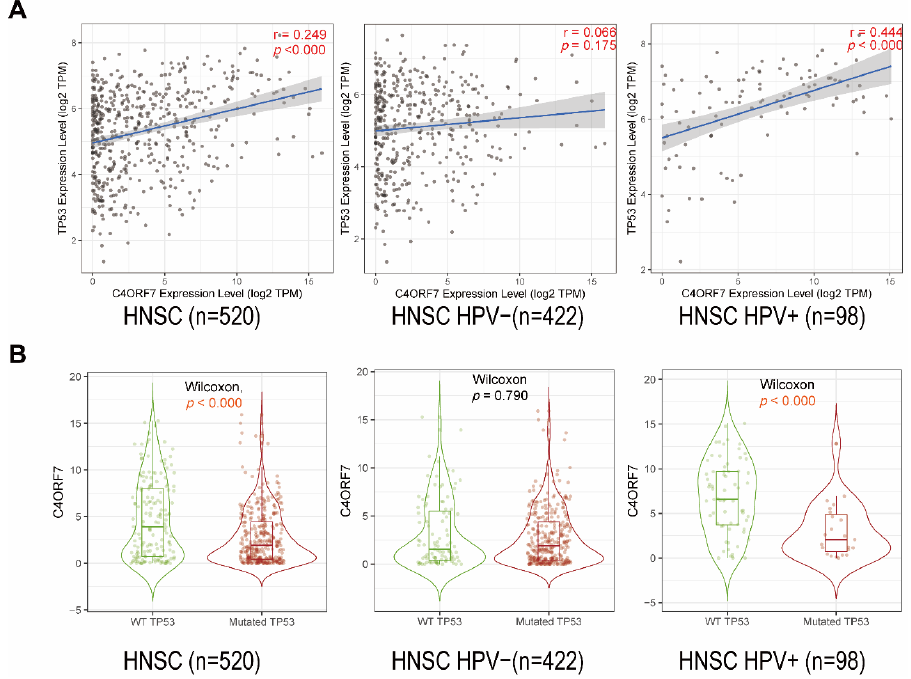
Figure 6. Correlation between FDCSP and TP53 in HNSC. ( A ) Correlation between FDCSP and TP53 expression (Spearman). ( B ) Violin plot and boxplot showed correlation of FDCSP with mutated/wild-type (WT) TP53, Wilcoxon algorithm was used for calculating statistical difference.